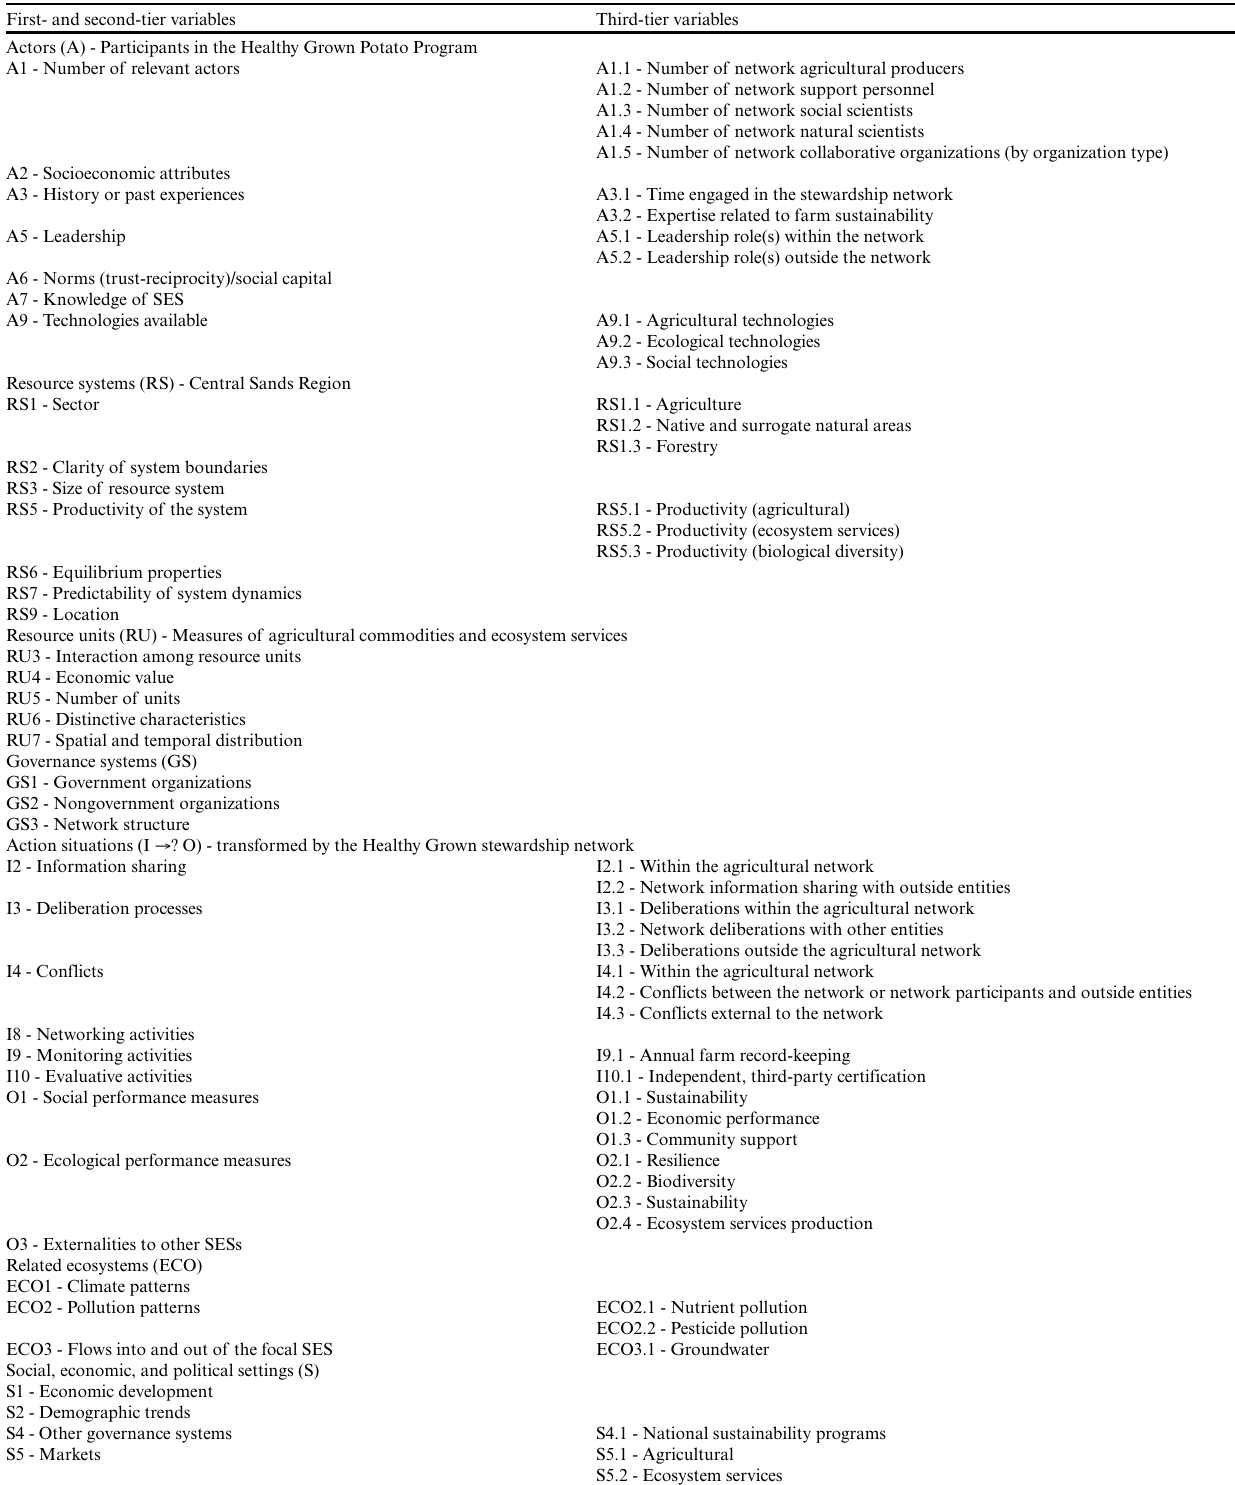
Table 2 . First-, second-, and third-tier variables of the social-ecological system (SES) that are relevant to the Healthy Grown stewardship network. Modified from McGinnis and Ostrom